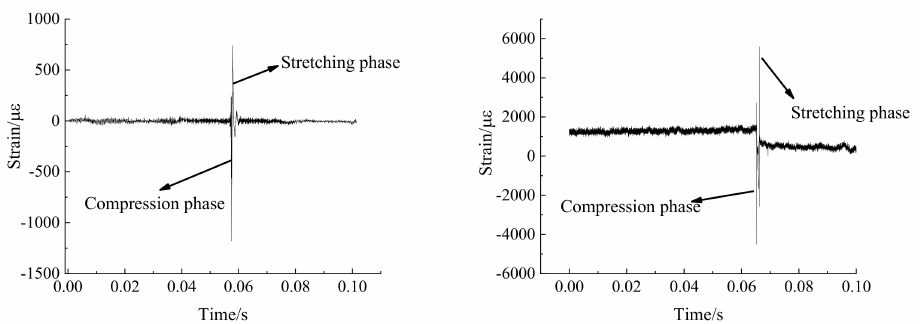
Figure 5. Strain wave in coal under the action of high-energy